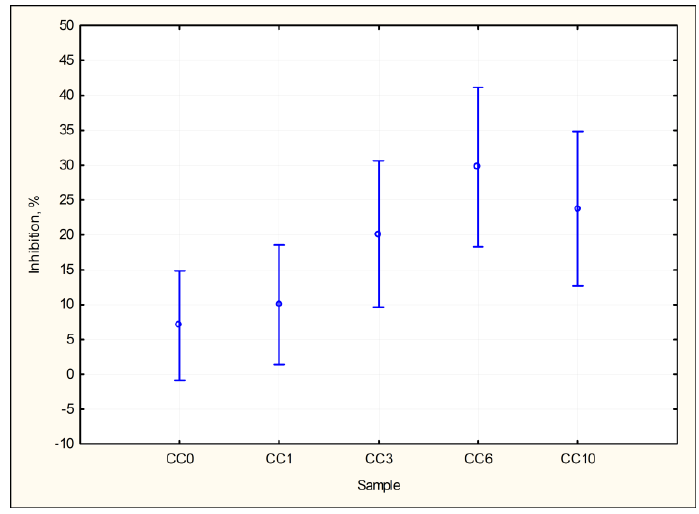
Figure 3. Graph of the 95% confidence intervals for inhibition by samples. Root growth inhibition test of Sinapis alba .